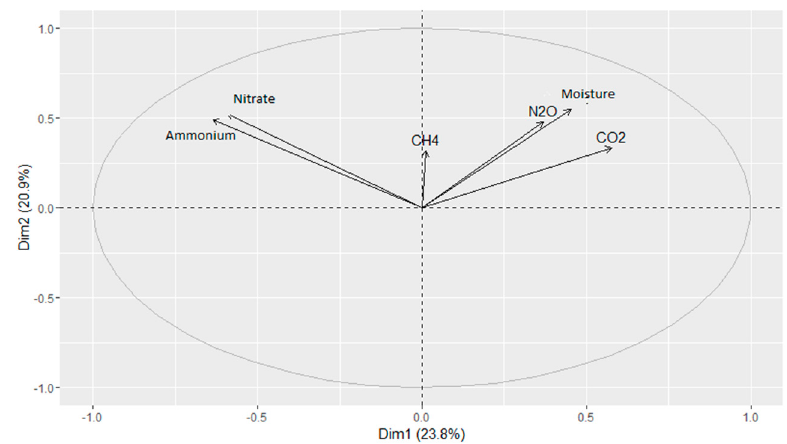
Figure 1. Principal Correlation Analysis between greenhouse gases and the explanatory variables for Marandu grass pastureland managed at different sward heights during the period 2012–2014. Dim1 (principal component 1) and Dim2 (principal component 1). Table 7. Cumulative N 2 O (kg N 2 O-N ha − 1 ), CH 4 (kg CH 4 -C ha − 1 ), and CO 2 (Mg CO 2 ha − 1 ) emissions for Marandu grass managed at different sward heights 1 . Sward Height (cm) 2